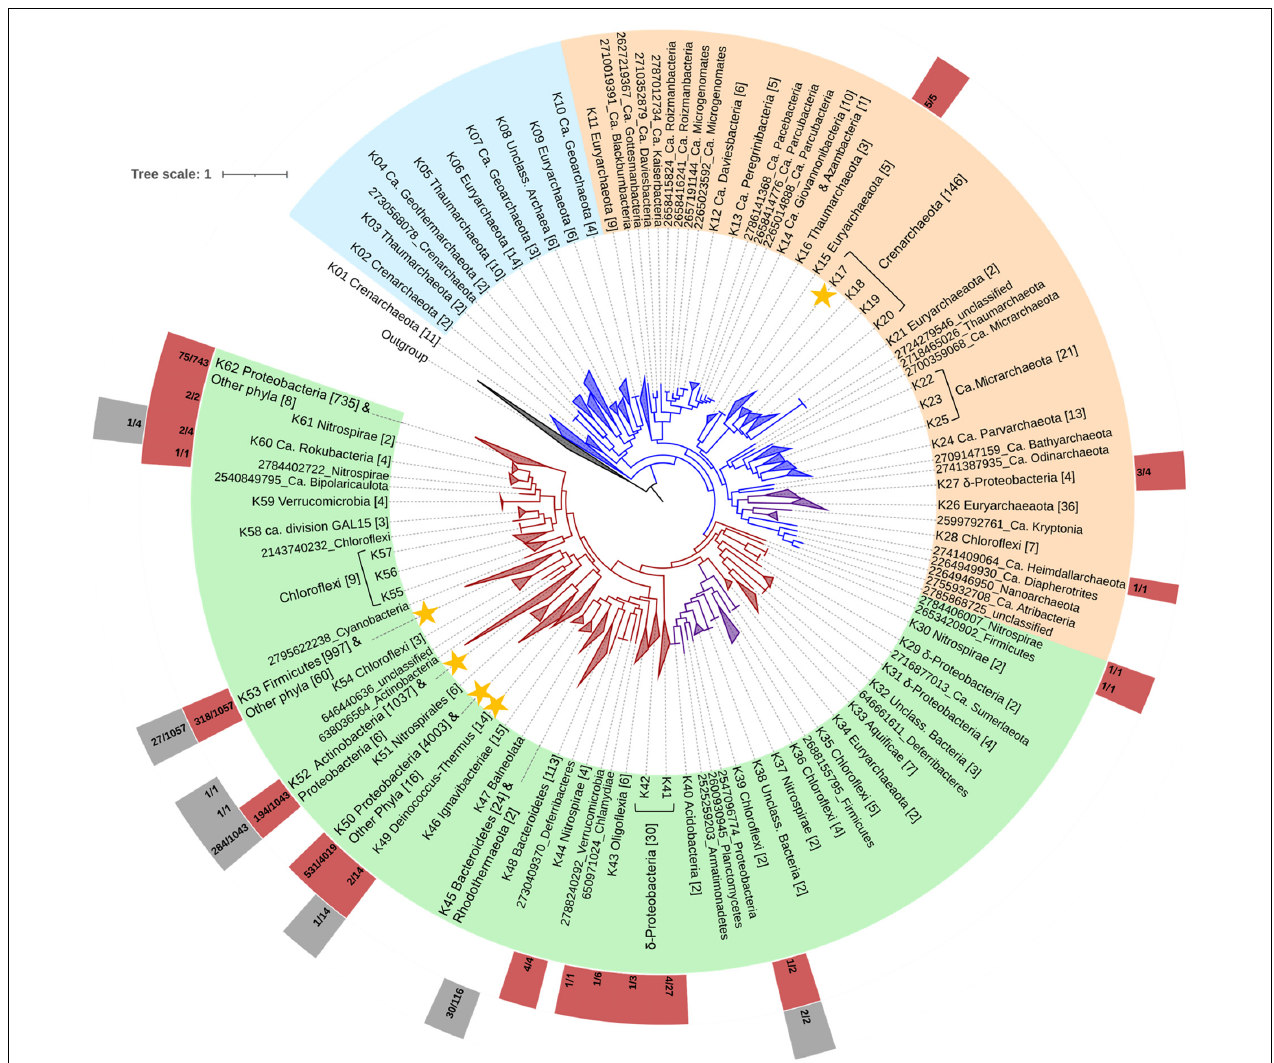
FIGURE 3 | Phylogenetic tree of MerA protein homologs (plasmid MerA not included). Archaeal and bacterial clades are denoted with blue and red color, respectively, while purple-colored clades denote mixed lineages. Colors covering labels of lineages denote the three primary groups of MerA: Group A (light blue), Group B (light orange) and Group C (light green). The outer boxes right to the labels show the presence of MerB (light red box) and MerB-like (gray boxes) homologs in the genomes from which the MerA homologs were derived. Numbers in the light red and gray boxes denote how many of the MerA-encoding genomes within each collapsed node also encoded MerB or MerB-like homologs, respectively. The outgroup consists of 6 bacterial and archaeal dihydrolipoamide dehydrogenase sequences. Tree scale is in amino acid substitutions per site. Yellow stars denote lineages with representatives which their MerA activity has been confirmed. Single lineages not grouped with other clades are depicted with their gene ID and phylum